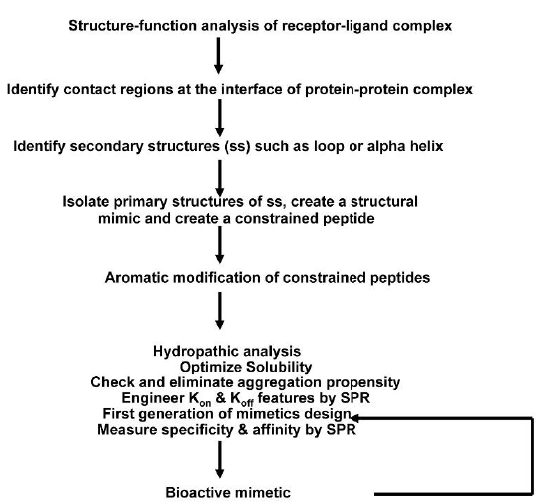
Figure 1. Overall scheme of the method used to create receptor complex peptide inhibitors. A systematic approach has been developed to design peptide inhibitors based on the three-dimensional structure of receptor–ligand complex, which involves peptide chemistry, computational biology, and use of surface plasmon resonance. 4.2. P185 neu/her2 (Her2) Receptor Complex Targeted Peptidomimetics: The ErbB receptor superfamily consists of four members: EGFR, Her2/neu, Her3, and Her4. Except for Her2/neu, all the members are known to be activated by ligands. EGF and TGF β can interact with EGFR. Neuregulin (NRG) can interact with Her3 and Her4. ErbB receptors are transmembrane proteins which possess extracellular or ligand binding domains, as well as transmembrane and tyrosine kinase domain in the cytoplasm. The extracellular domain consists of four subdomains including Leucine-rich repeat do- mains (SbdI and SbdIII) and cysteine-rich domains (SbdII and SbdIV) arranged in an al- ternate manner. Crystal structure studies of this family of receptors has revealed that the overall topology is conserved across ErbB receptors [38 – 40]. Furthermore, crystal struc- tures show that Her2/neu exists as tethered [41] dimer and constitutively active. Other members undergo larger conformational rearrangement upon ligand binding for activa- tion (formation of stable dimers) of the receptors [39]. The key feature of the erbB receptors is two long loops emanating from domain II (S21) and domain IV (S22) that exist in an extended state in Her2 and closed/open state in other erbB receptors; the closed state is considered inactive, and the extended state is considered as an active form (Figure 2). No- tably, the Her2/neu receptor remains extended and is not known to exist in a closed form, suggesting that Her2/neu preferably forms a stable dimeric complex.